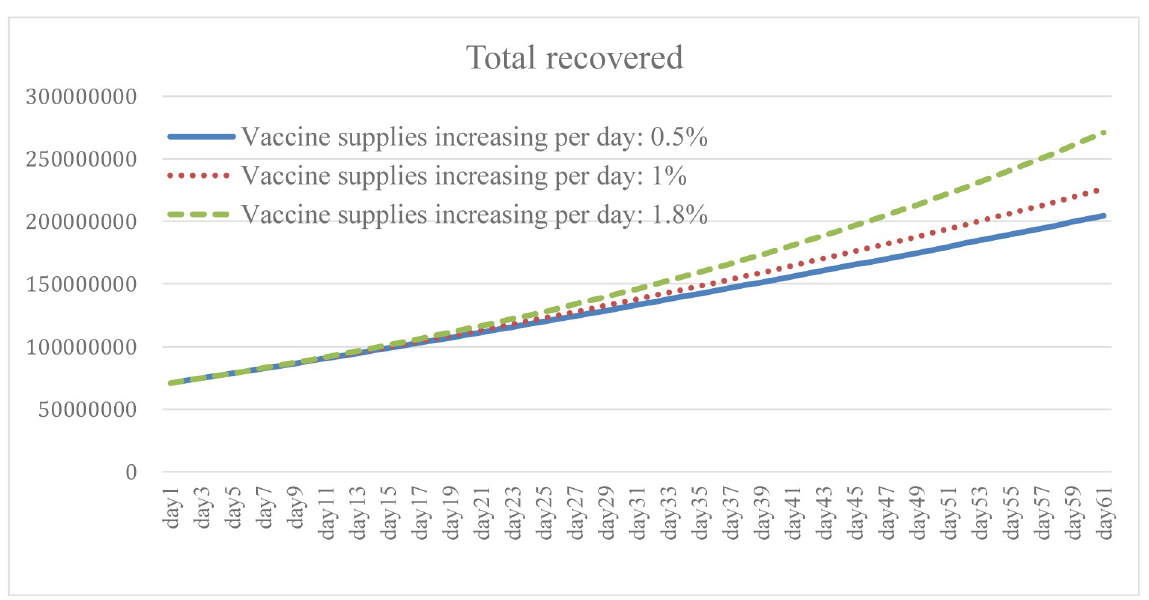
Fig 12. Total recovered under different vaccine supply.